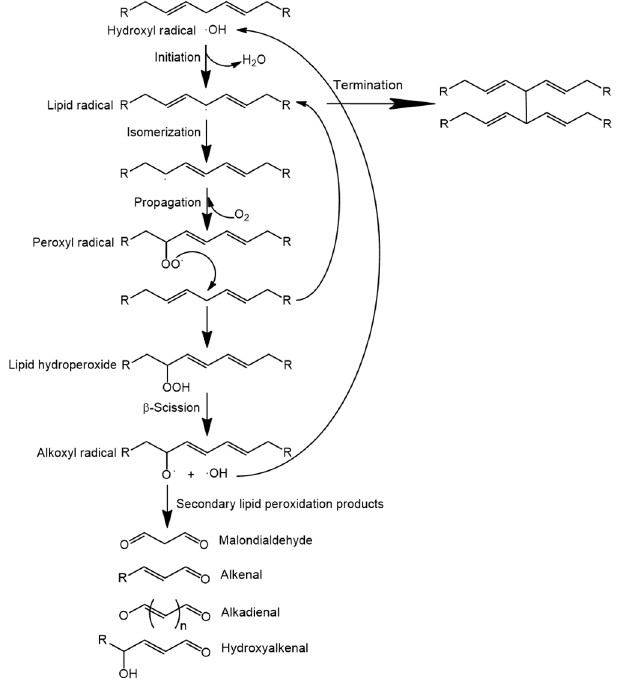
Figure 3. Oxidative processes involving polyunsaturated fatty acids and secondary lipid peroxidation products generated, involved in rancid odor.